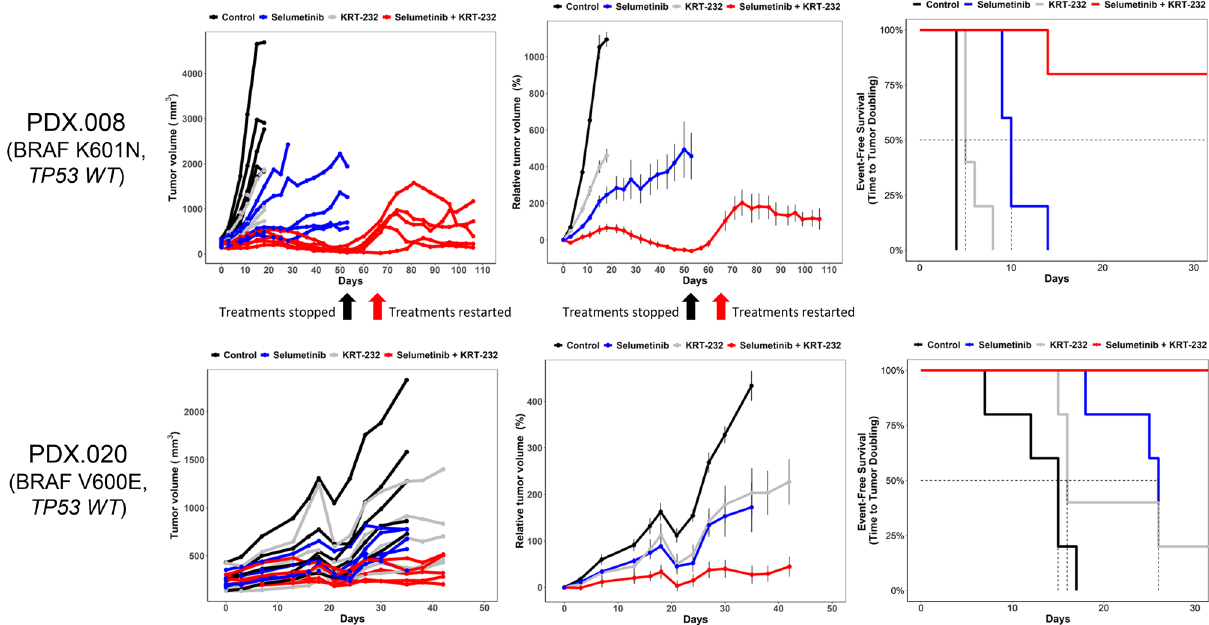
Figure 4. Selumetinib combined with KRT-232 inhibits tumor growth in PTC PDX models. Female athymic nu/nu mice bearing PTC PDXs were treated with vehicle, selumetinib 25 mg/kg, KRT-232 15 mg/kg, or the combination of both. Selumetinib and KRT-232 were both administered daily. Left panel, individual tumor volume change (mm 3 ). Middle panel, growth curve graphs demonstrating mean change in tumor volume percentage ± SEM. Right panel, EFS curves. PDX.008: black arrow, complete regression on day 54, treatments stopped; red arrow, 100% increase in tumor size and treatments restarted on day